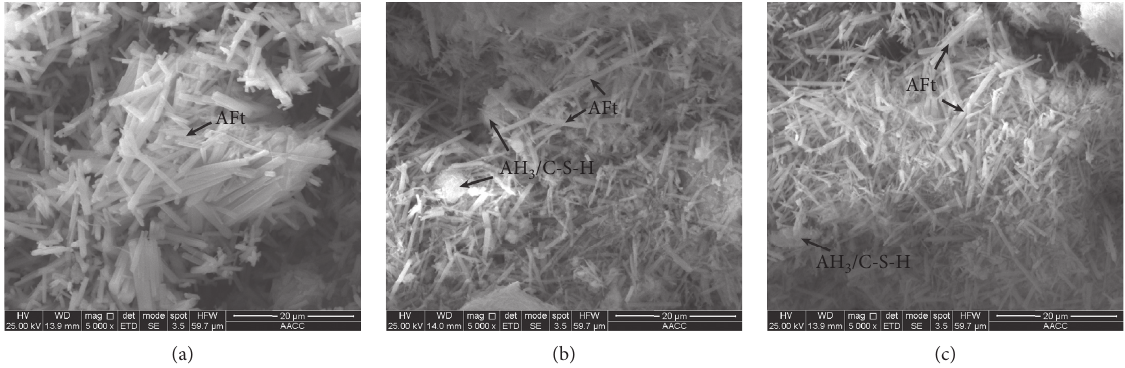
Figure 3: Micromorphology of NCG concretion. (a) W1 N. (b) W2 N. (c)